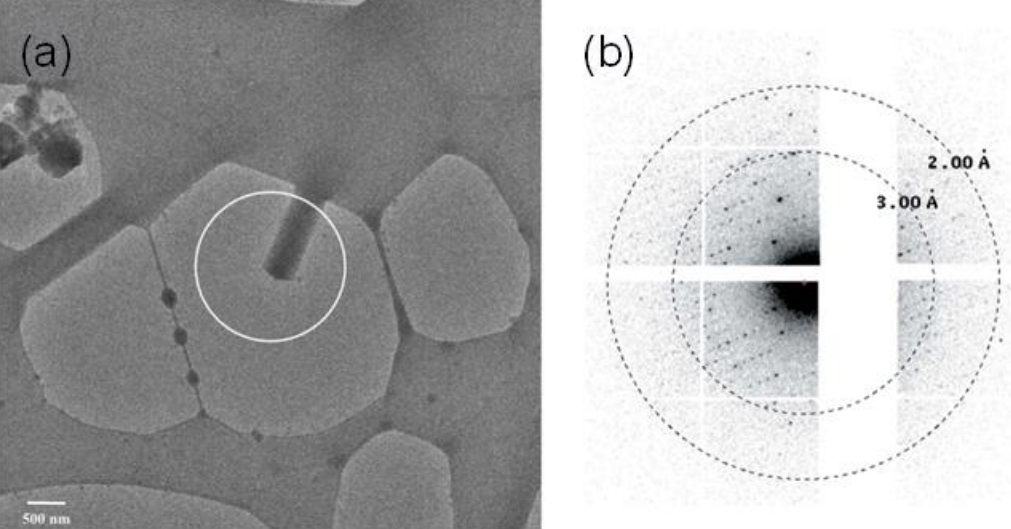
Figure 2. ( a ) Electron micrograph of a nanocrystal and ( b ) the diffraction from the selected area in the micrograph. (Adapted from Clabbers et al. [3]).